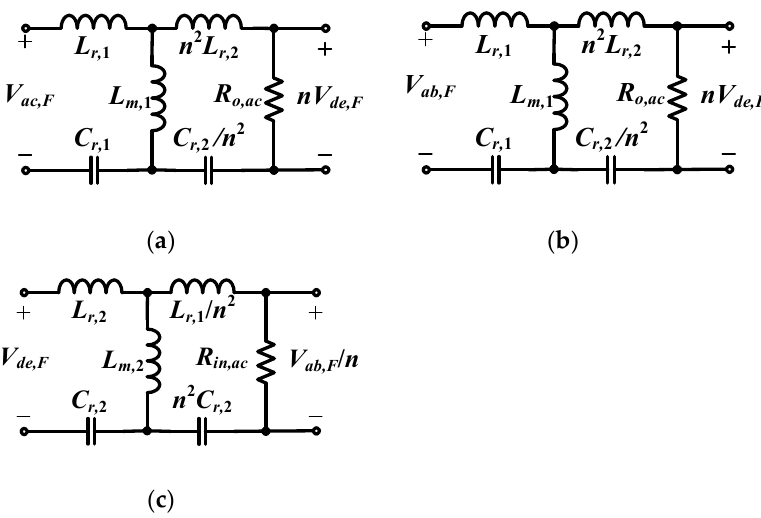
Figure 8. The equivalent resonant circuits at fundamental switching frequency under ( a ) low-output voltage range and forward power operation; ( b ) high-output voltage range and forward power operation; ( c ) backward power operation.